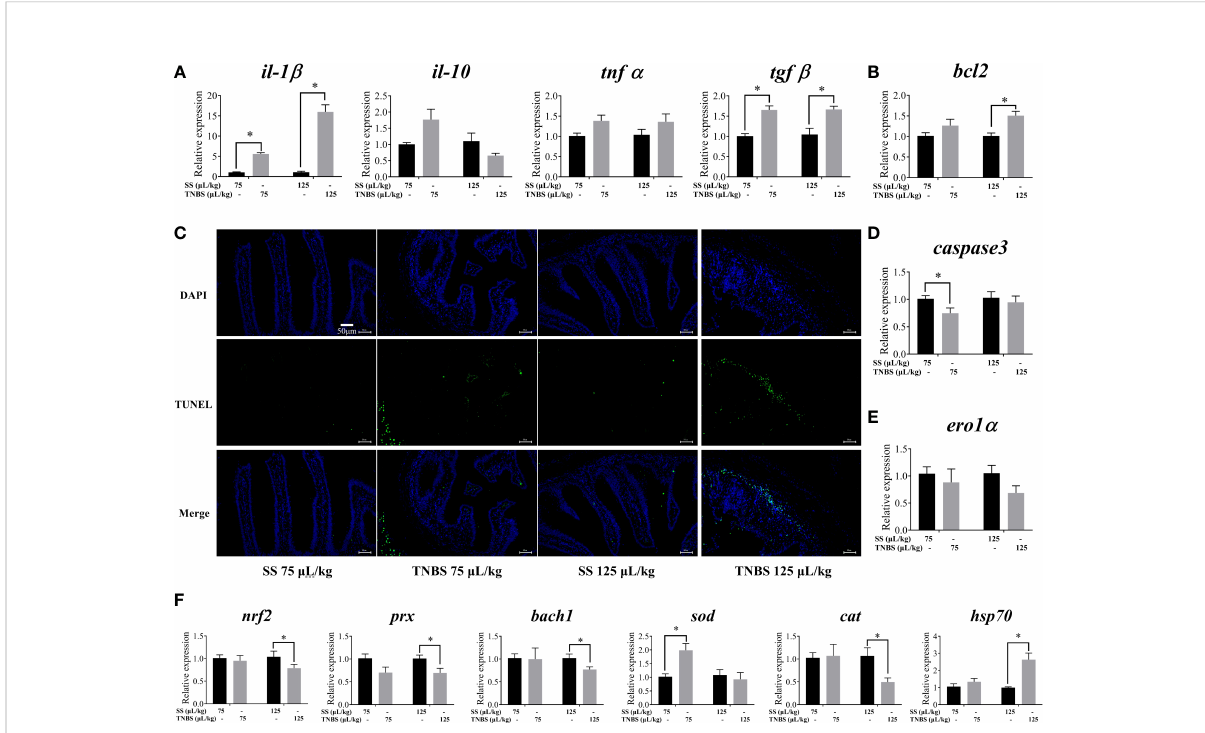
FIGURE 2 The effect of TNBS on the intestinal in fl ammation, apoptosis and oxidative damage. (A) mRNA levels of in fl ammatory cytokines. (B, D, E) Relative mRNA levels of apoptosis related genes. (C) Representative DAPI and TUNEL double staining of gut (scale bar: 50 m m). (F) mRNA levels of oxidative-related genes. All data are expressed as mean ± S.E.M. (N = 6 at least). P value was calculated by Student ’ s t tests. * P < 0.05, compared with PBS